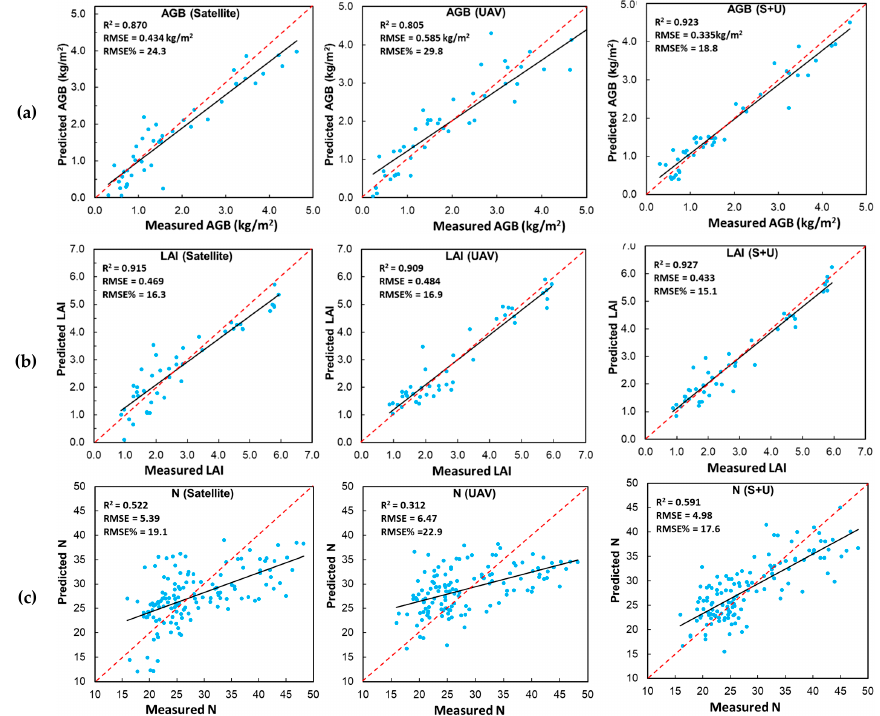
Figure 9. The cross-validation measured against ELR-based predicted variables AGB ( a ), LAI ( b ), and N ( c ) when using satellite, UAV, and satellite + UAV data. The red dash line is the bisector, and the black solid line is the linear regression fitting line; S+U represents combing satellite and UAV data. The combination of satellite spectral information with UAV-derived structure features yielded higher estimation accuracies, as well as the convergence of the linear fitting line.